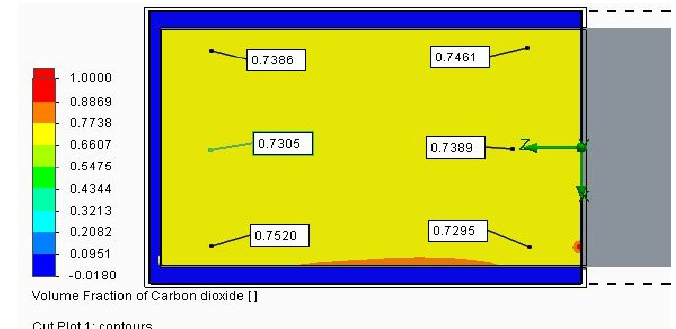
Figure 6. CFD concentrations on the horizontal 25 cm-high cut plane for a chamber with a 12 mm-wide slot running the length of the long walls near the top edge. Results are for the end of the 5 min pumping period with 100% CO inlet 2